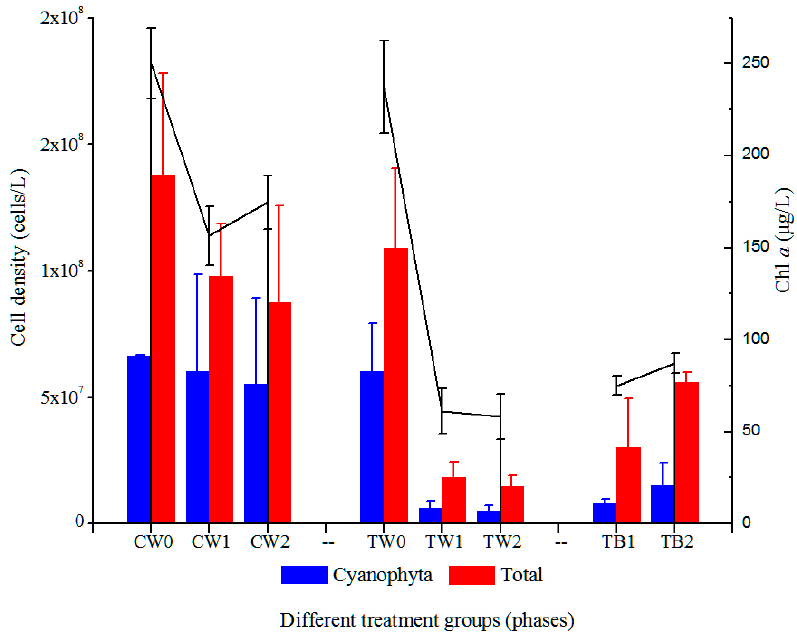
Figure 4. Variation of cell density relative to total algae (including cyanobacteria), and the corresponding concentration of Chl a (shown as black line) in all enclosures. Error bars represent standard deviation (n = 3 × 2). Designations 0, 1, and 2 represent days 0, 30, and 60, respectively.